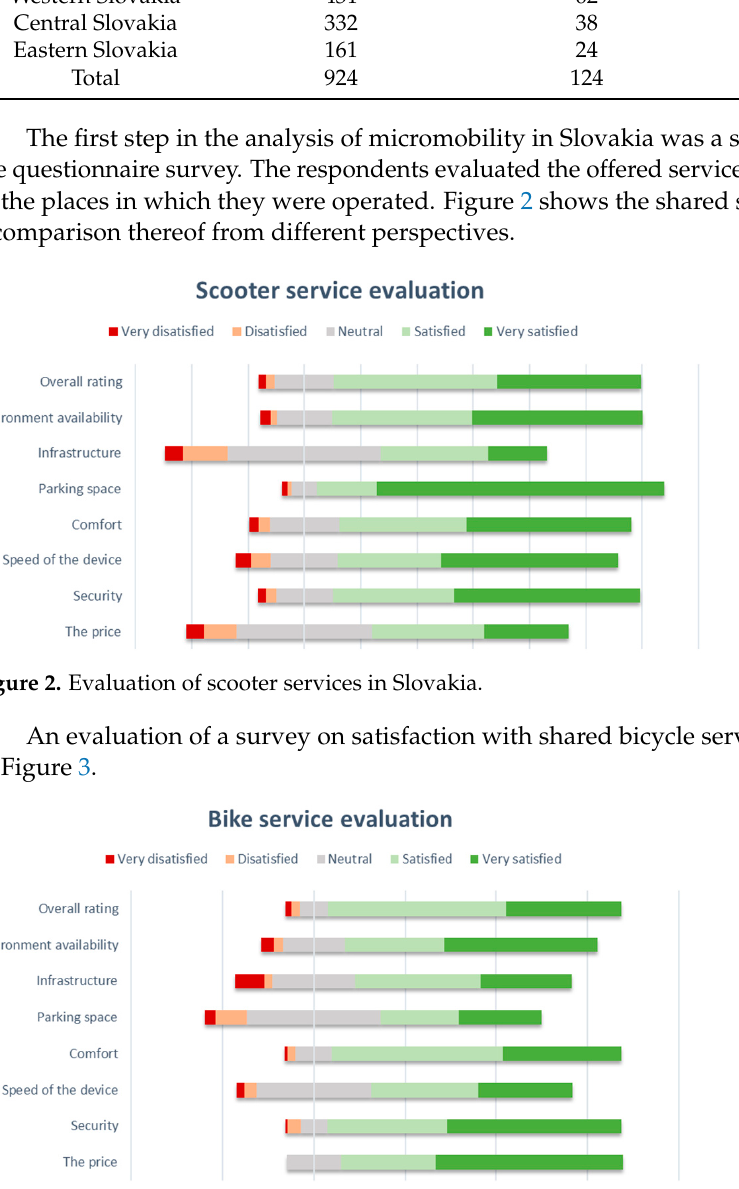
Figure 3. Evaluation of bike services in Slovakia.